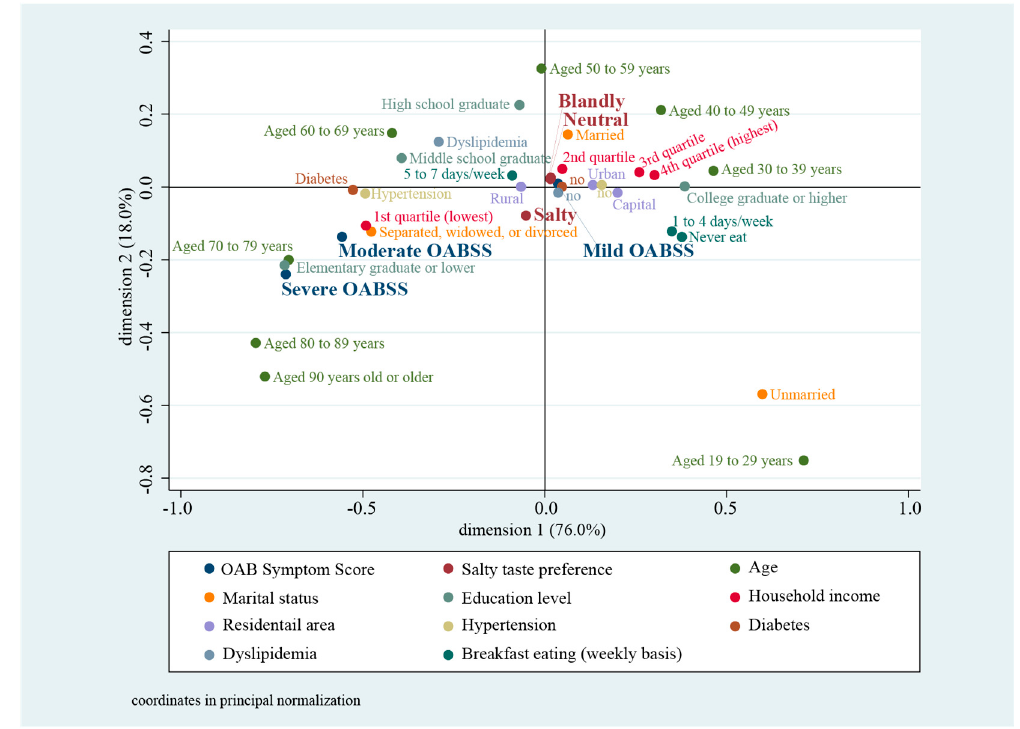
Figure 2. Multifactorial relationship between overactive bladder symptom, salty taste preference, socioeconomic, comorbidity, and dietary behavior. OABSS, overactive bladder symptom score.